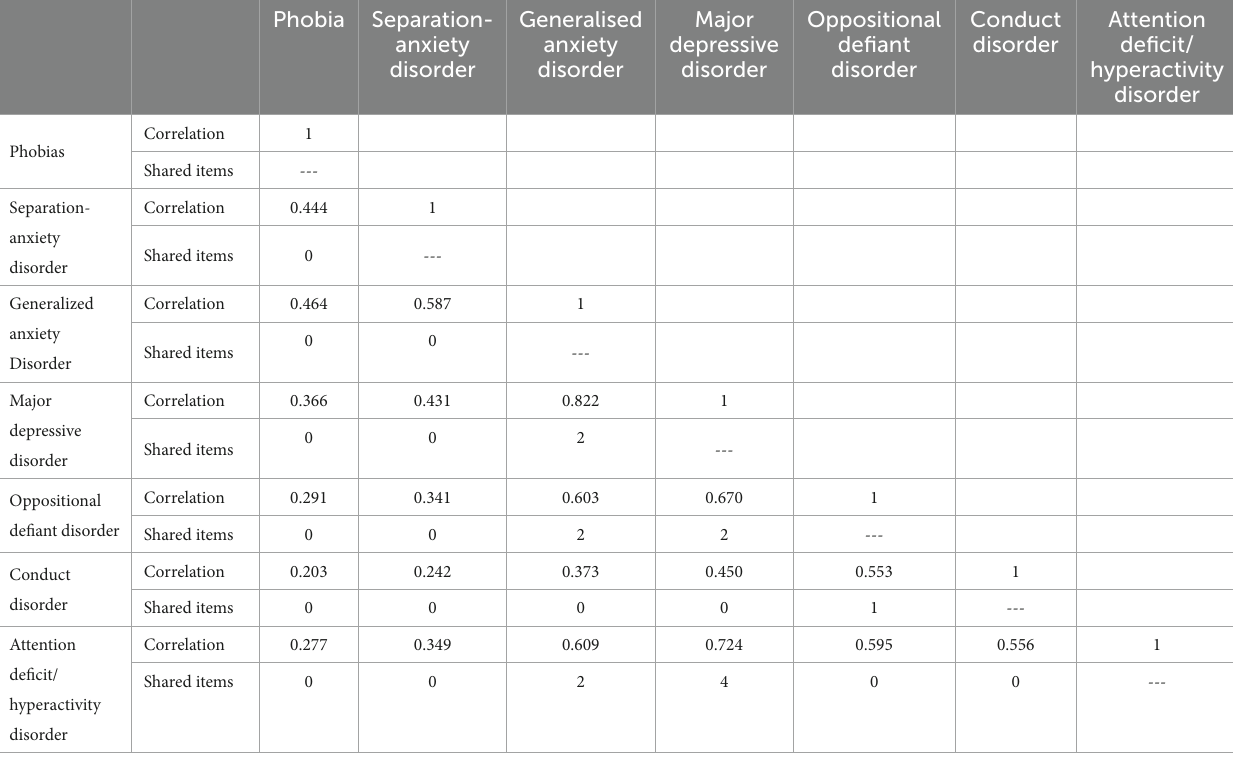
TABLE 4 Correlation of the item scores for the seven diagnostic-specific subscales of the Dominic Interactive self-completion video game among 1,479 primary school children in Tianjin, China 1 and number of shared items (DI questions) used in both of the DI diagnosis considered in each correlation